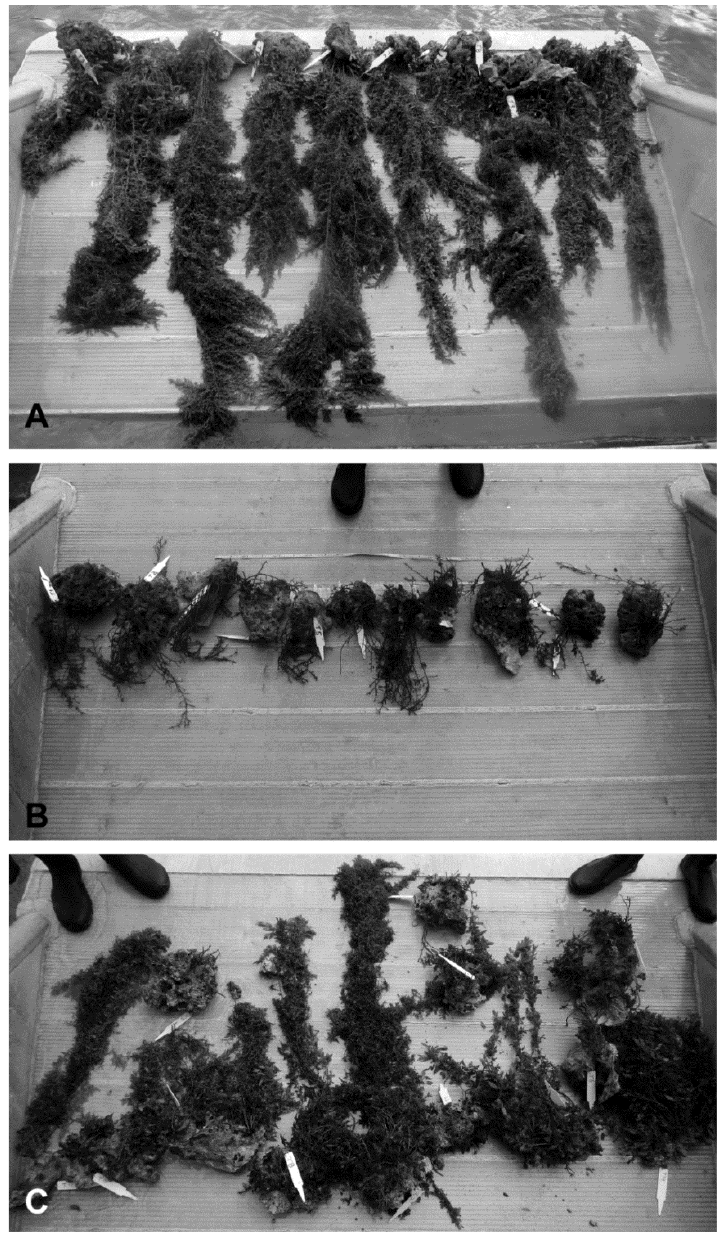
Figure A1.1. A Standard macroalgal bioassays upon deployment. B Macroalgal bioassays collected 24 hours later for every deployment 1996-2010 (and 2011-2013 second annual deployments). This extent of removal was considered ‘largely removed’. C Macroalgal bioassays collected 24 hours after first annual deployment 2011-2013. Barring the three rocks to the top of the image, this degree of removal would be considered ‘largely